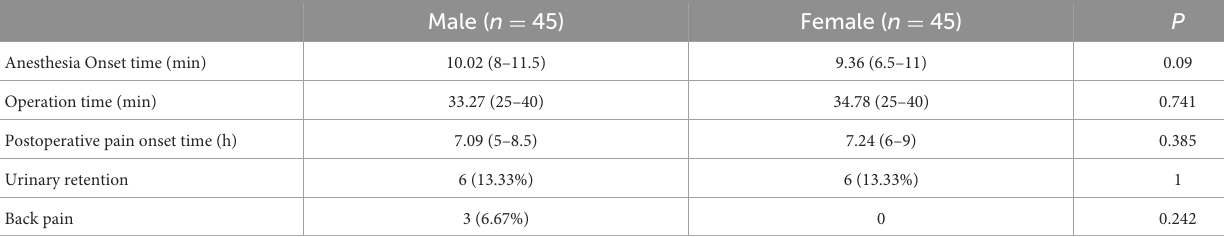
TABLE 3 Caudal epidural block characteristics and block